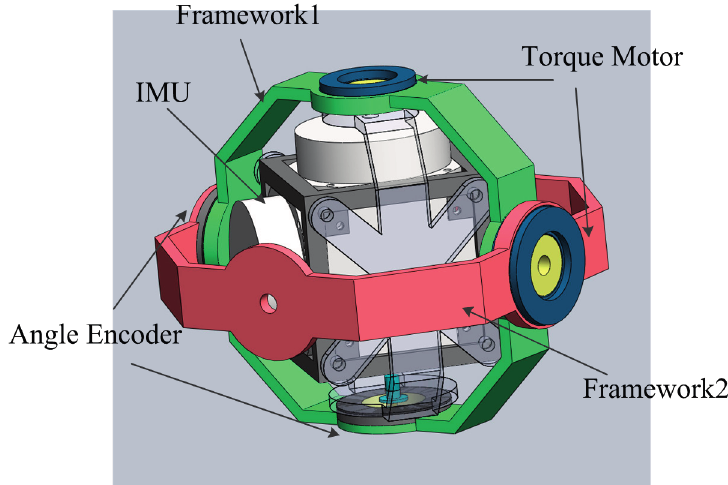
Figure 1. The RINS structure.